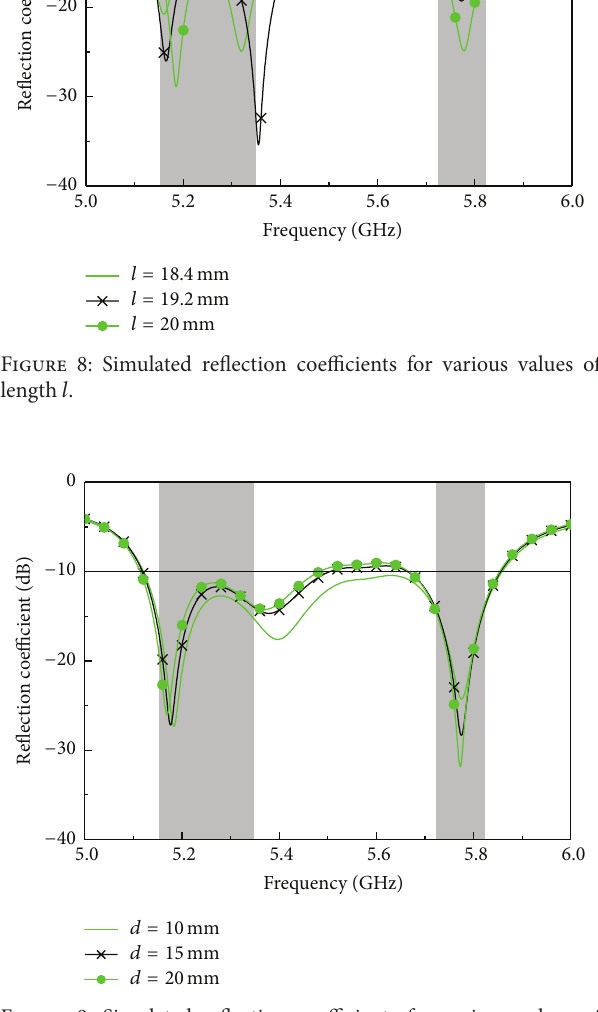
Figure 9: Simulated reflection coefficients for various values of distance 𝑑